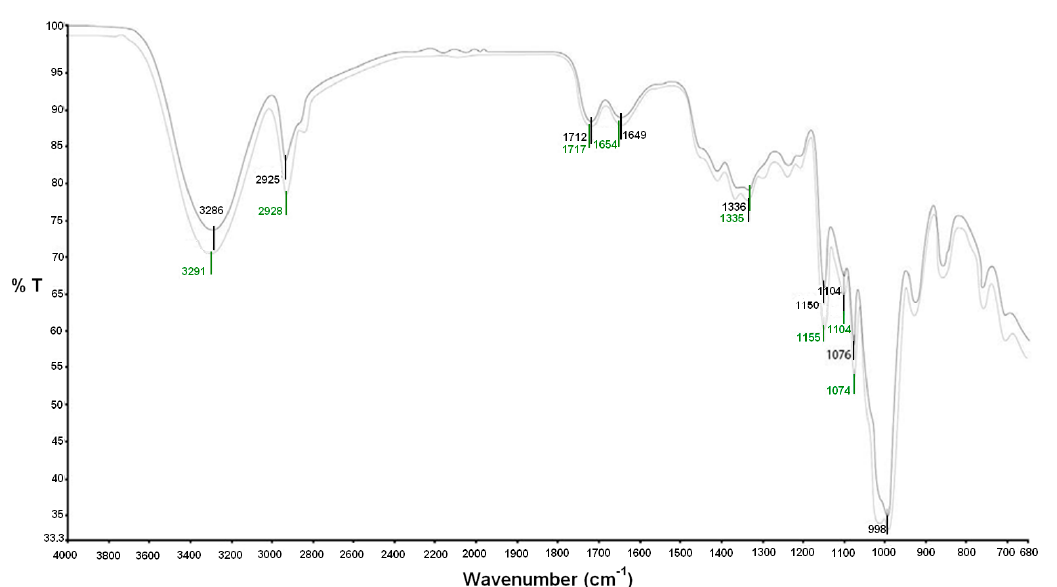
Figure 11. FTIR spectra carried out on the material newly produced (darker curve) and then subjected to UV ageing (lighter curve).